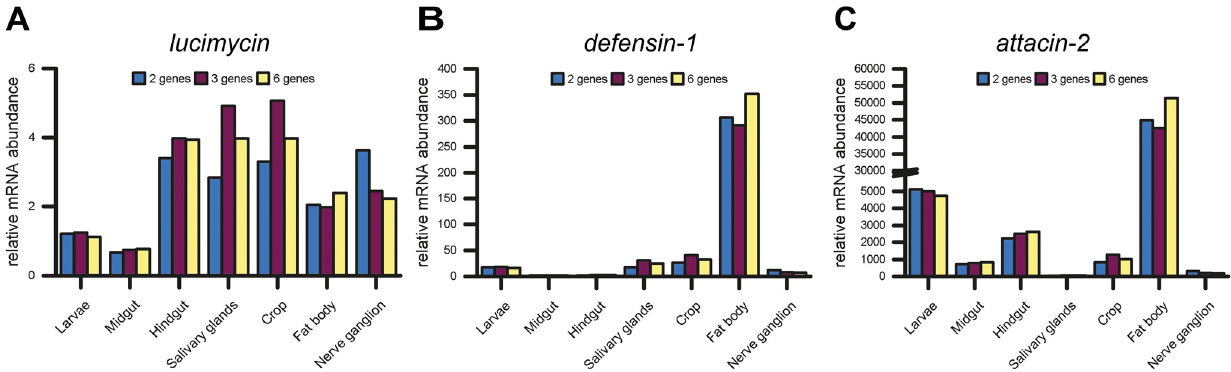
Fig 4. Quantitative RT-PCR analysis of lucimycin , defensin-1 and attacin-2 upon immune challenge. The mRNA expression of lucimycin (A), defensin-1 (B) and attacin-2 (C) was determined in different L . sericata tissues. Relative mRNA expression levels of individual immune genes were compared in between immune-challenged and na ï ve samples and normalized with two, three or six reference genes.